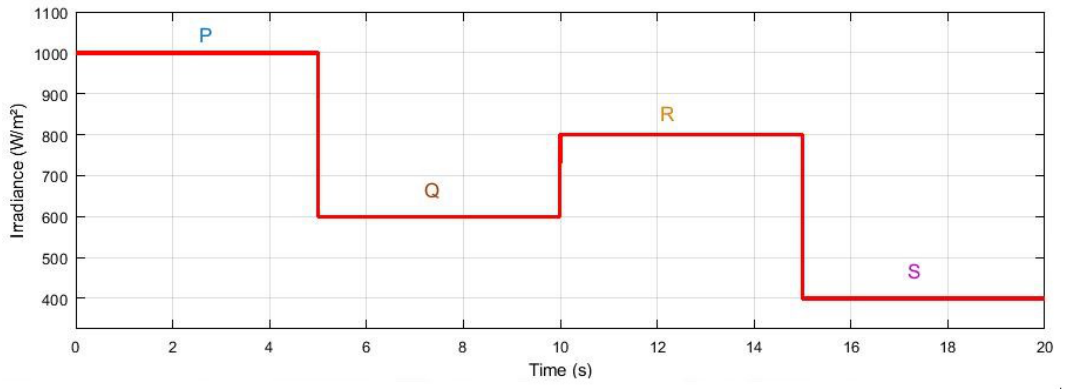
Figure 9. Irradiance profile of the whole panel without shading.